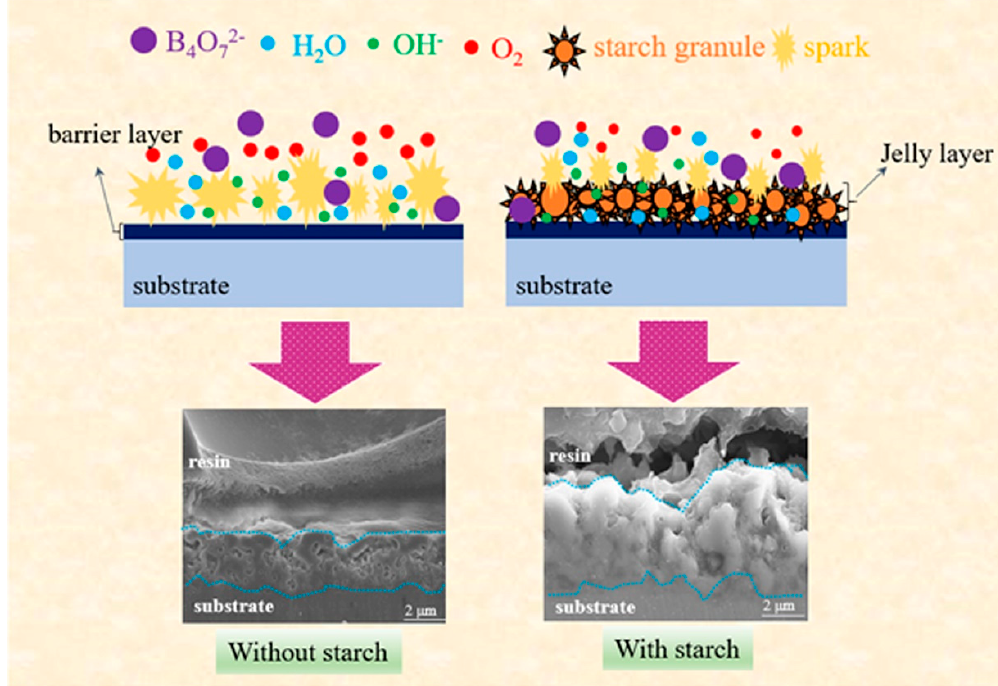
Figure 8. Schematic diagrams showing the formation mechanism for the coatings obtained in an electrolyte without and with starch. A jelly layer was formed in the case of electrolyte-containing starch, leading to generate uniform fine plasma sparks responsible for the formation of a relatively thick layer with fewer structural defects. Reprinted from permission from [39]. Copyright 2019 Elsevier.